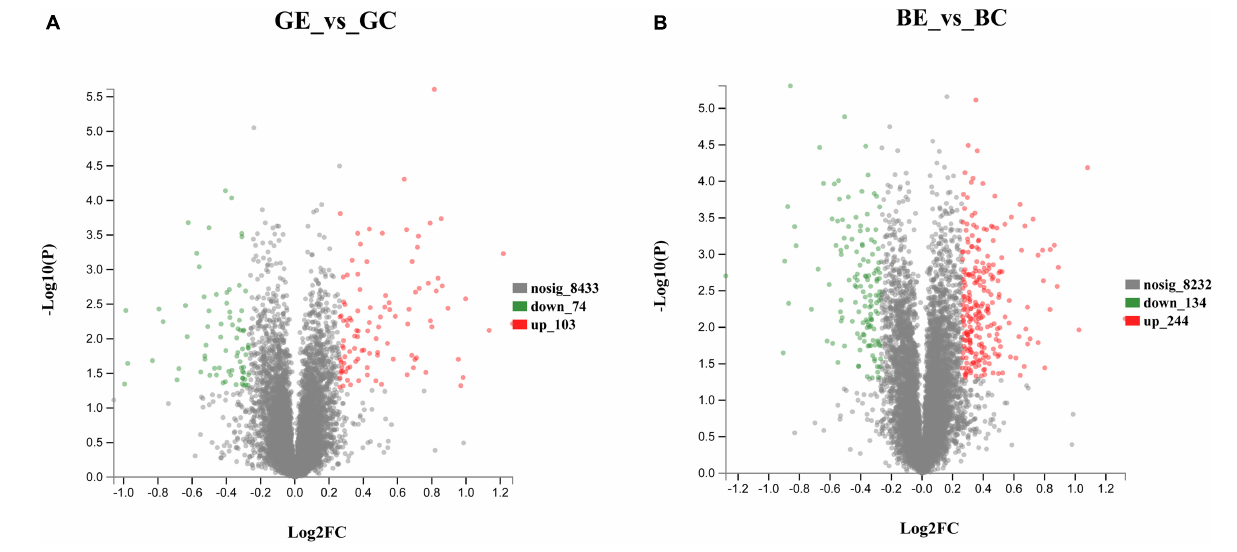
FIGURE 4 | Volcano plots showing the differentially expressed protein allocation in the sugarcane varieties GT11 (A) and B8 (B) after the inoculation of E. roggenkampii ED5 as compared to control. Each data point represented the differential expression of the protein in the volcano plot. Downregulated differentially expressed proteins were shown with green dots, upregulated differentially expressed proteins were marked with red dots, and non-differentially expressed proteins were labeled by gray dots. Protein ratios with p -value < 0.05, fold change > 1.20 (upregulated), or < 0.83 (downregulated) were significantly differently expressed.